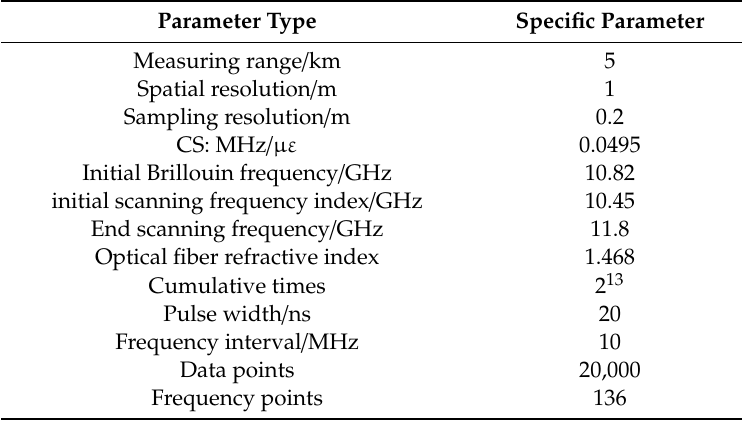
Table 3. Actual parameters used in field test of